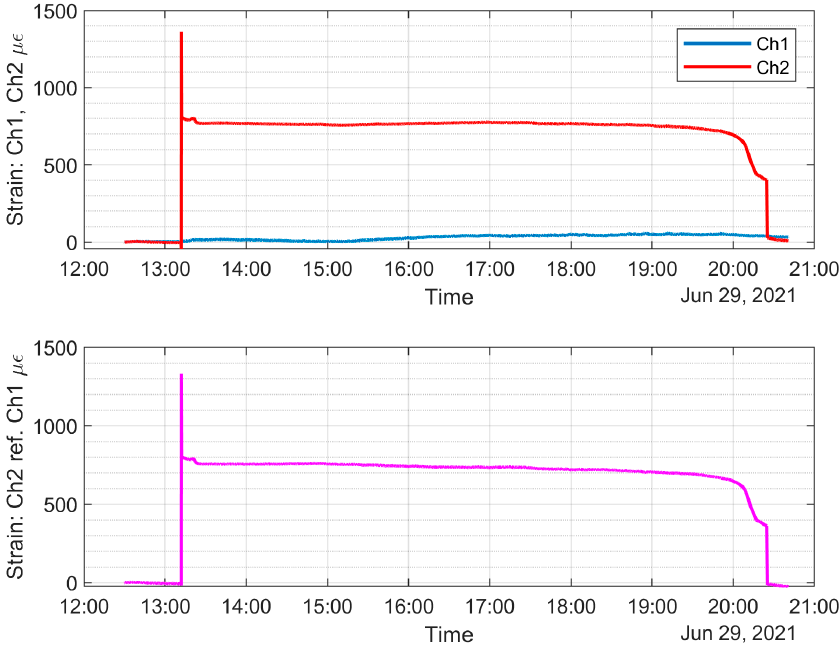
Figure 19. Top plot: strain on both FBGs without temperature compensation. Bottom plot: temperature ‐ compensated strain on the corrosion detection sensor.